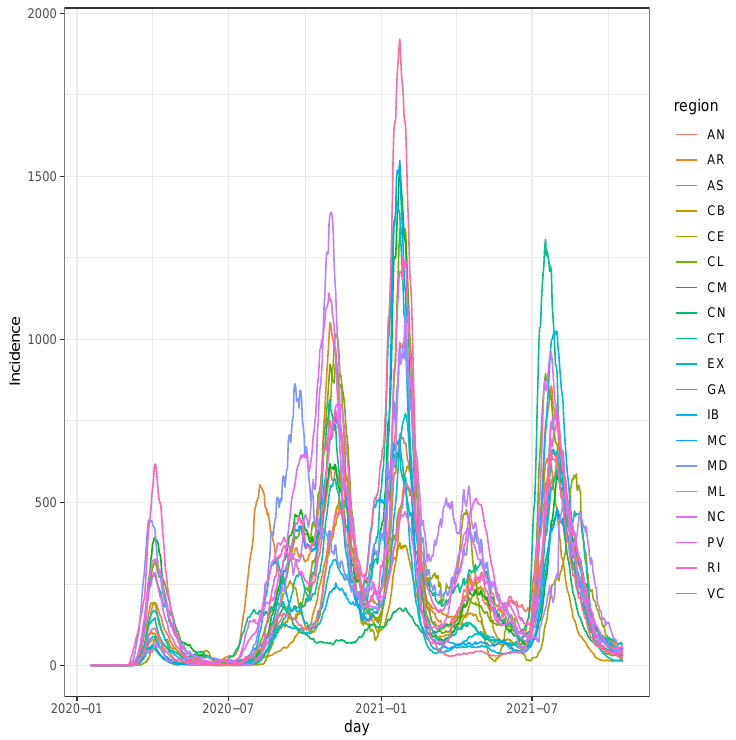
Figure 1. Observed cumulative incidence at 14 days for the 19 Spanish regions. The period starts 18 January 2020 and ends on 18th October 2021 for a total number of T = 640 days by S = 19 regions. ISO standards (https://en.wikipedia.org/wiki/ISO_3166-2:ES (accessed on the 25 October 2021)) represent the Spanish regions in all figures and